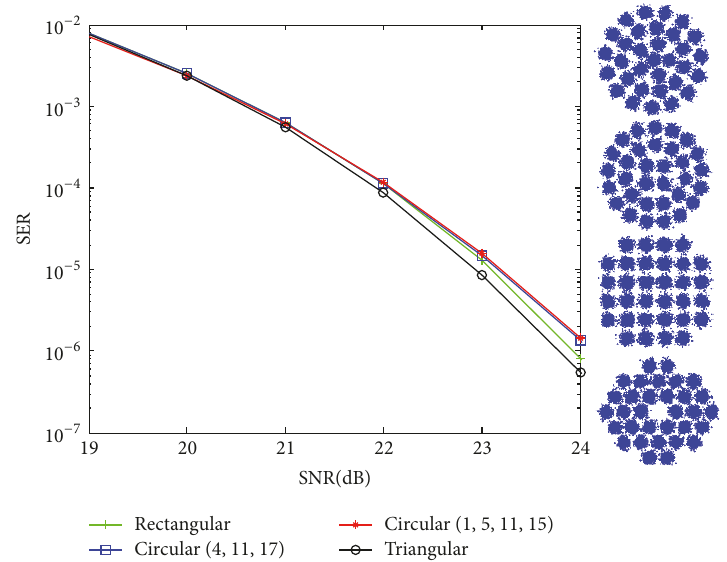
Figure 2: SER versus SNR.